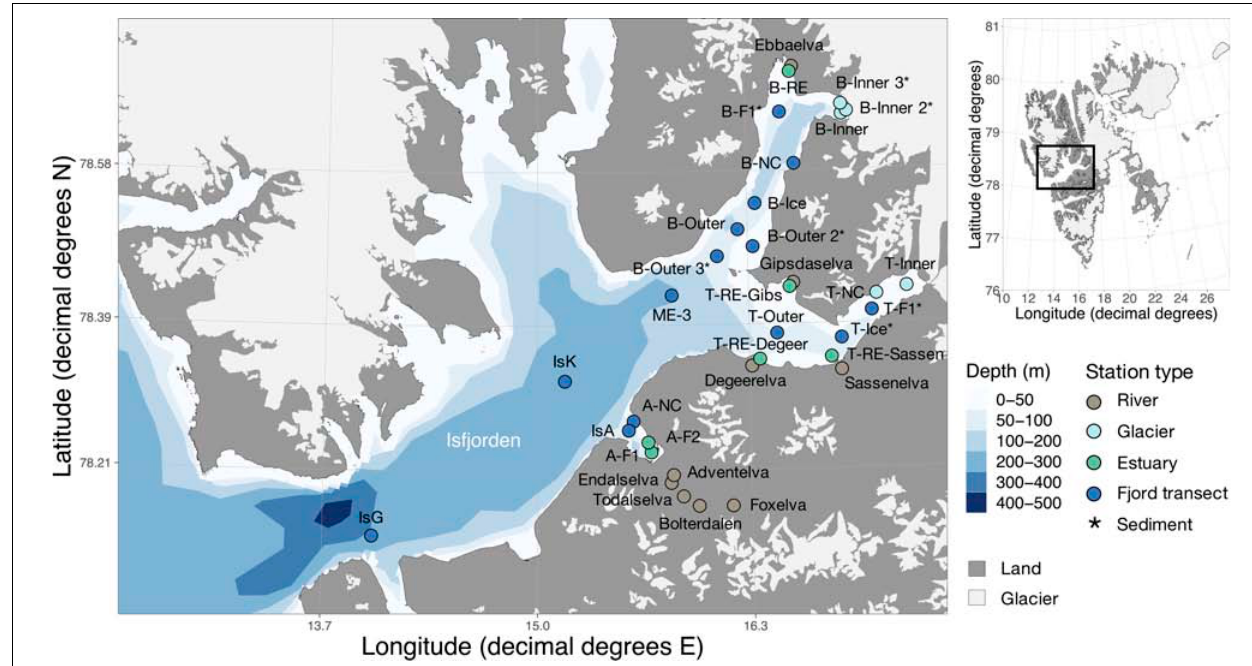
FIGURE 1 | Station map of Isfjorden. Water column samples were collected from two depths in June and August 2018. Color of the symbols indicates the location in the fjord. An asterisk at the station name indicates sites where only sediments were collected. Other stations include both water column samples and sediment samples. Glaciers are represented in light-gray and land in dark-gray. The insert marks the location of the fjord in Svalbard. Details of the sample names, coordinates, location and type are available in Supplementary Table 1 . The map was made using PlotSvalbard (v0.8.11) in R (Vihtakari, 2019). The Svalbard map originates from the Norwegian Polar Institute (2020, CC BY 4.0 license) and the bathymetry shapefile from the Norwegian Mapping Authority (2020, CC BY 4.0 license).